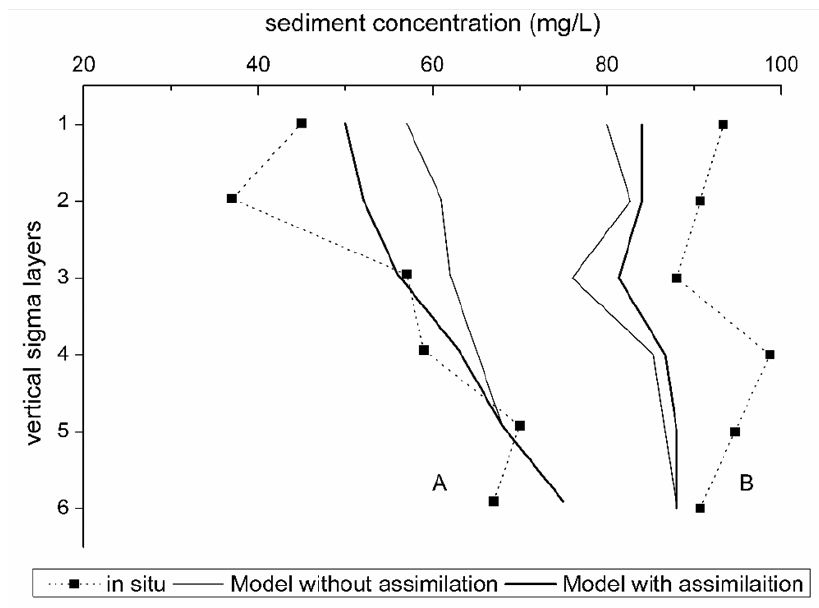
Figure 8. Vertical distribution comparison at site S7 at half an hour after the first assimilation time ( A ) and at half an hour after the second assimilation time ( B